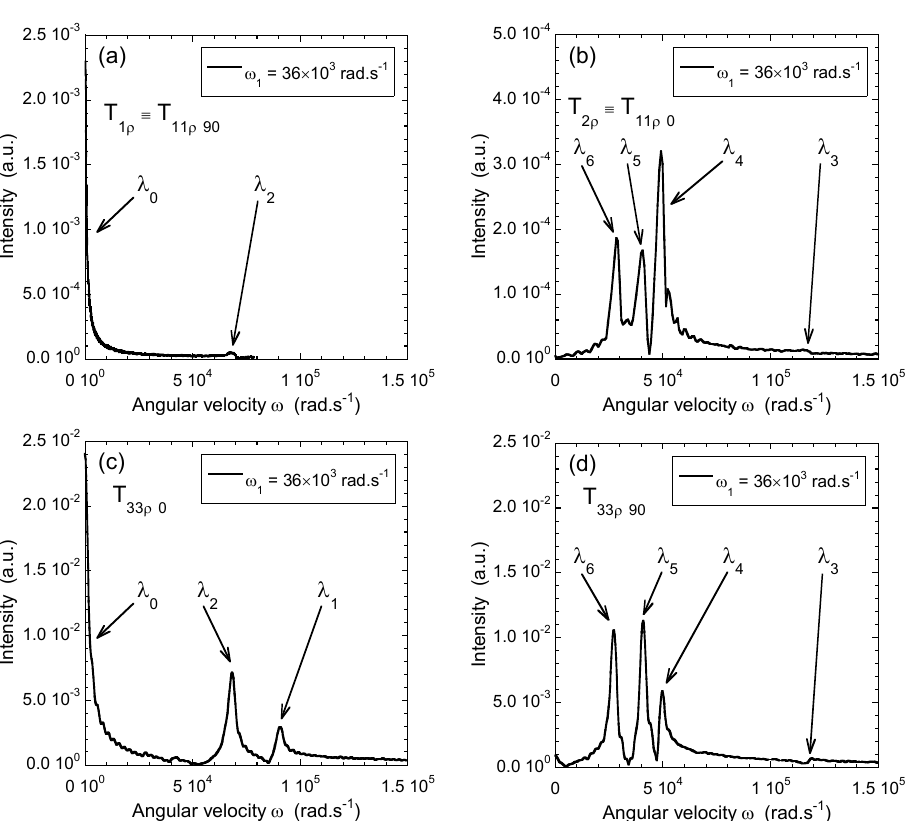
Figure 11. Fourier transform of the time evolution of the 7 Li coherences, ( a ) T 11 ( a ) ; ( b ) T 11 ( s ) ; ( c ) T 33 ( s ) and ( d ) T 33 ( a ) , under spin-locking conditions, illustrating the whole set of characteristic angular velocities k i ; see Equation (7). Reprinted with permission from Ref. [41]. Copyright (2009) American Chemical Society.